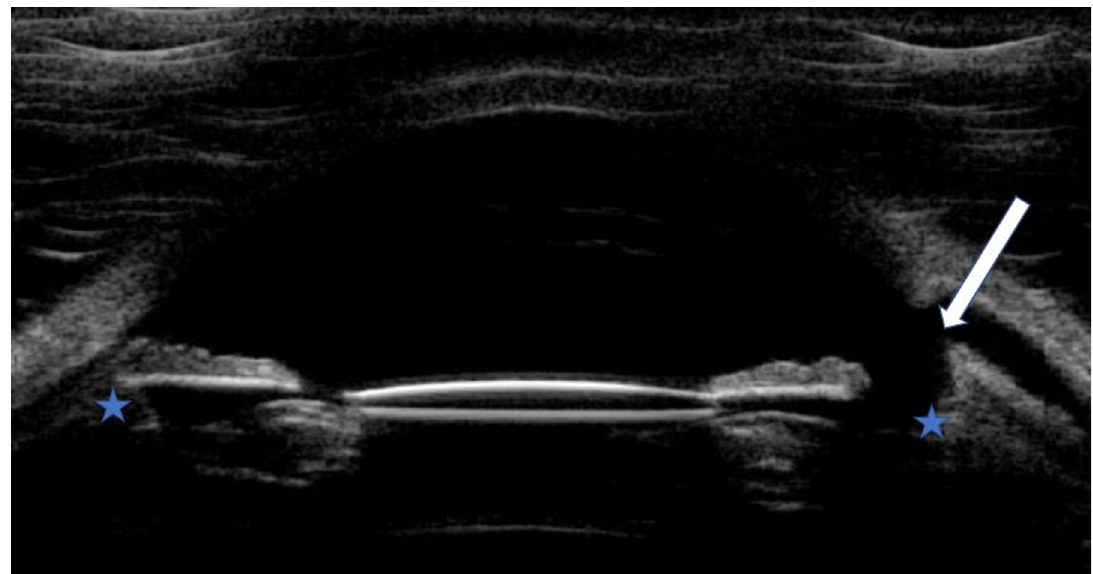
Fig 1. Ultrasound biomicroscopy vertical image in a refractory glaucoma (previous trabeculectomy). Blue stars, ciliary bodies; white arrow, trabeculectomy site.